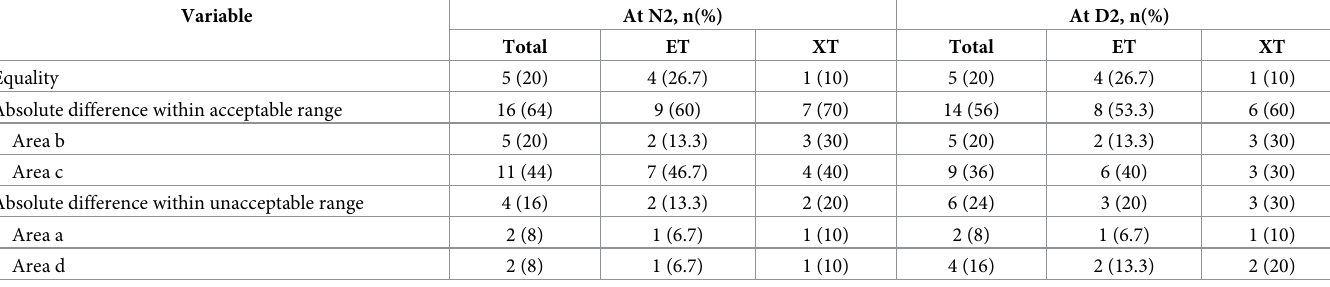
Table 2. Summary results of correlation between angle of deviation from the Krimsky with the APCT.